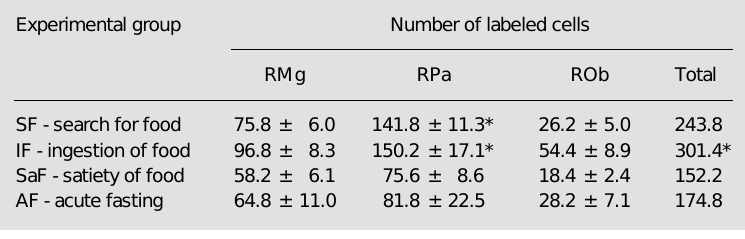
Figure 1 - Photomicrographs of transverse sections of the rat brainstem at bregma -10.96 de- picting c-Fos-immunopositive cells in animals under different conditions of food restriction. Chronic fasting animals allowed only to search for food (A); in- gestion of food (B); satiety of food (C), and acute fasting (D). The arrows indicate the raphe nucleus region: black arrows the pallidus (RPa), and open arrows the magnus